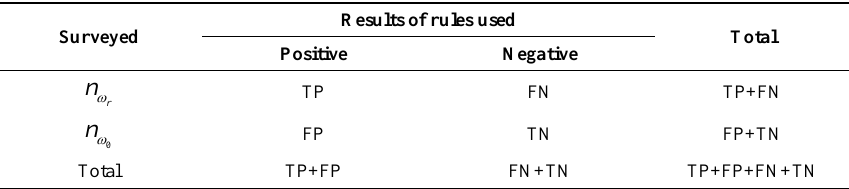
Table 3. Control test results